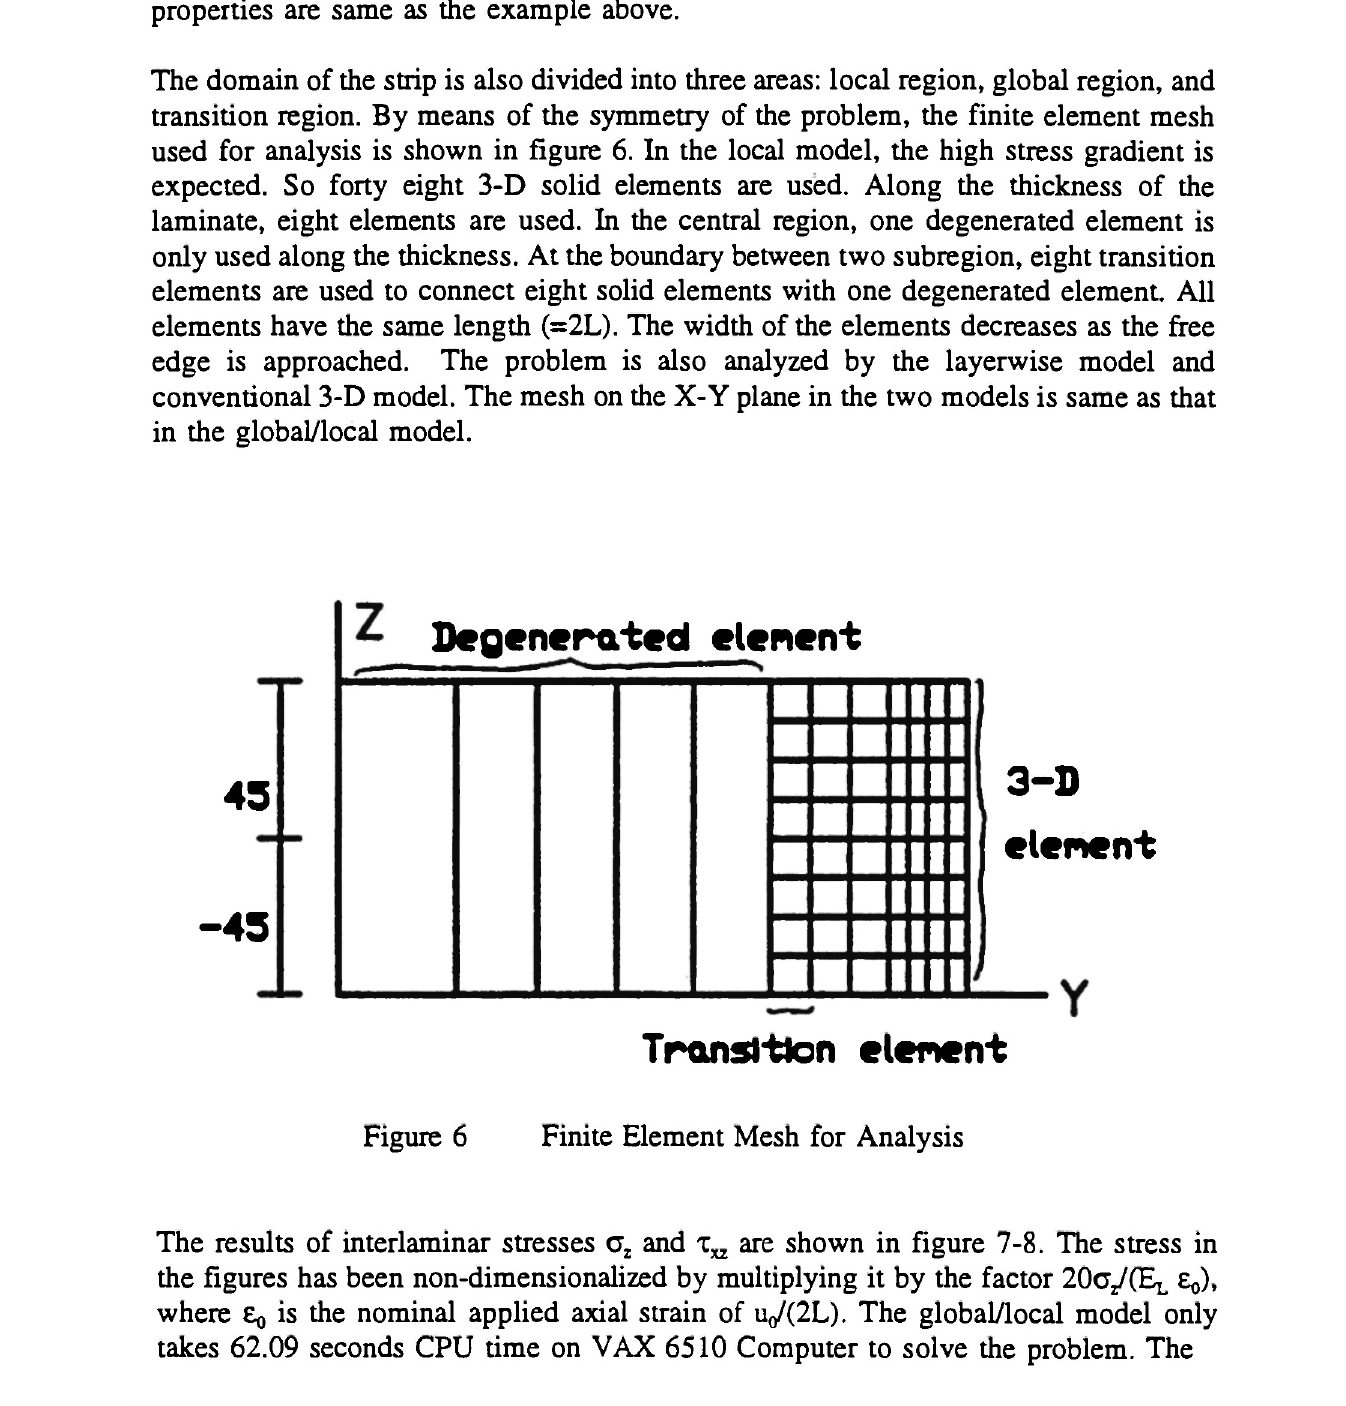
Figure 6 Finite Element Mesh for